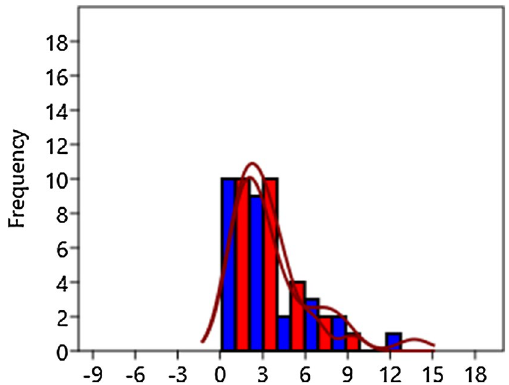
Fig. 5 Frequency with kernel density